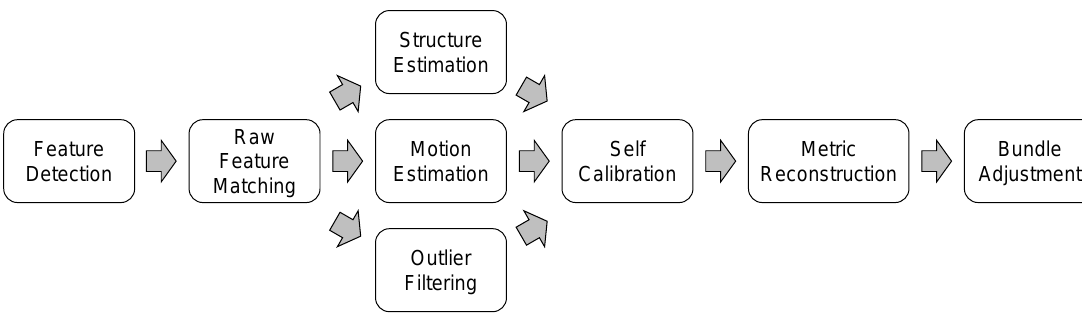
Figure 2. The Structure-from-Motion